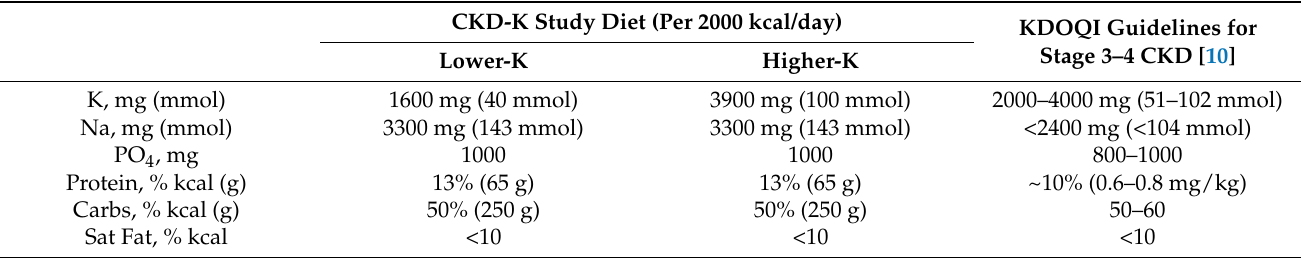
Table 1. Study Diets Compared to National Kidney Foundation Guidelines. CKD-K Study Diet (Per 2000